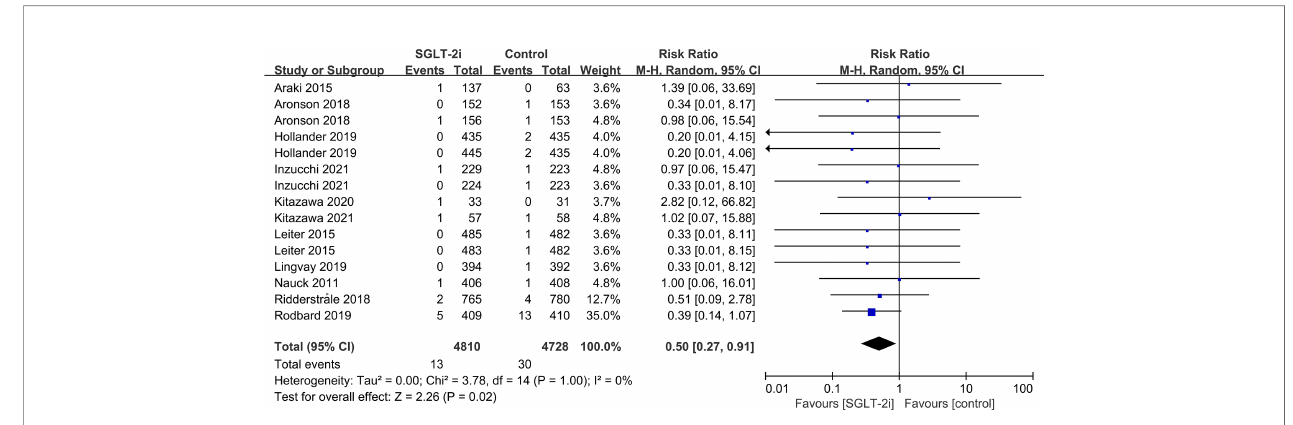
FIGURE 8 | Effect of SGLT-2i on incidences of retinal disease compared with active hypoglycemic agents in T2DM